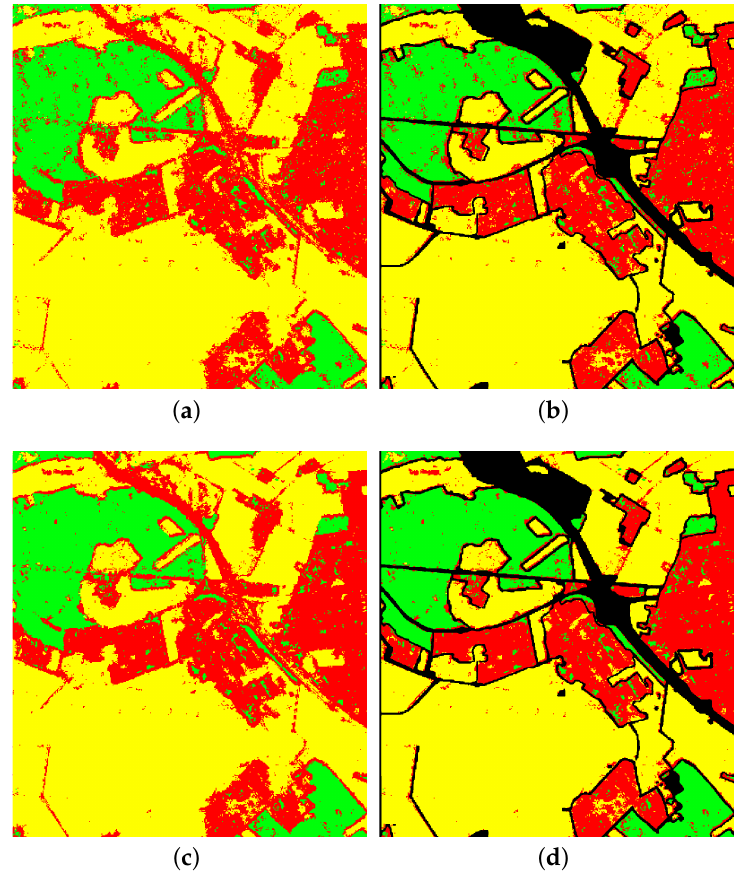
Figure 16. The visual classification results by CNN and QCNN on Oberpfaffenhofen data set. ( a ) The classification result obtained by CNN. ( b ) The result map ( a ) overlaids with the ground truth map. ( c ) The classification result obtained by QCNN. ( d ) The result map ( c ) overlaids with the ground truth map.